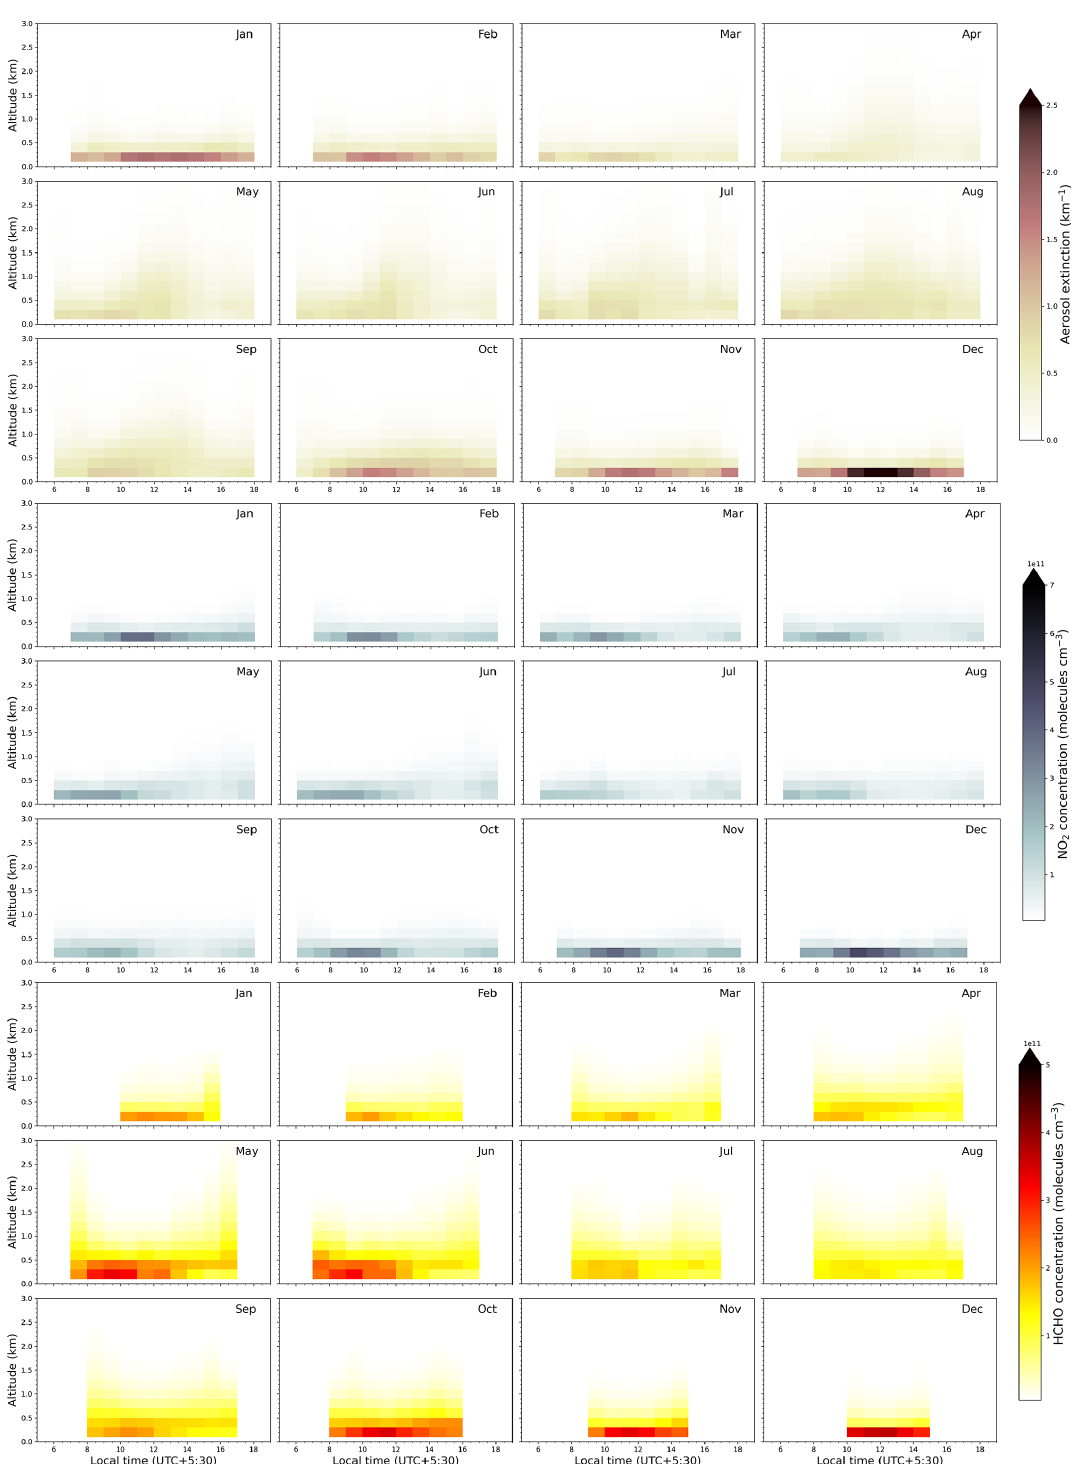
Figure 5. Hourly mean vertical profiles of aerosol extinction (top three rows, shades of olive), NO 2 concentrations (middle three panels, shades of blue) and HCHO concentrations (bottom three panels, shades of red) in different months retrieved from 4.5 years of MAX-DOAS measurements over